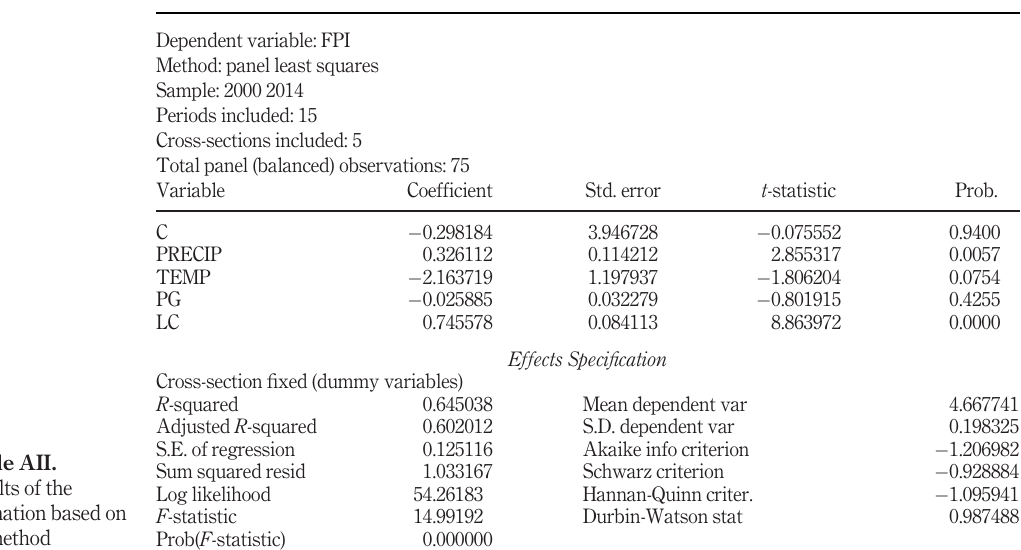
Table AII. Results of the estimation based on FE